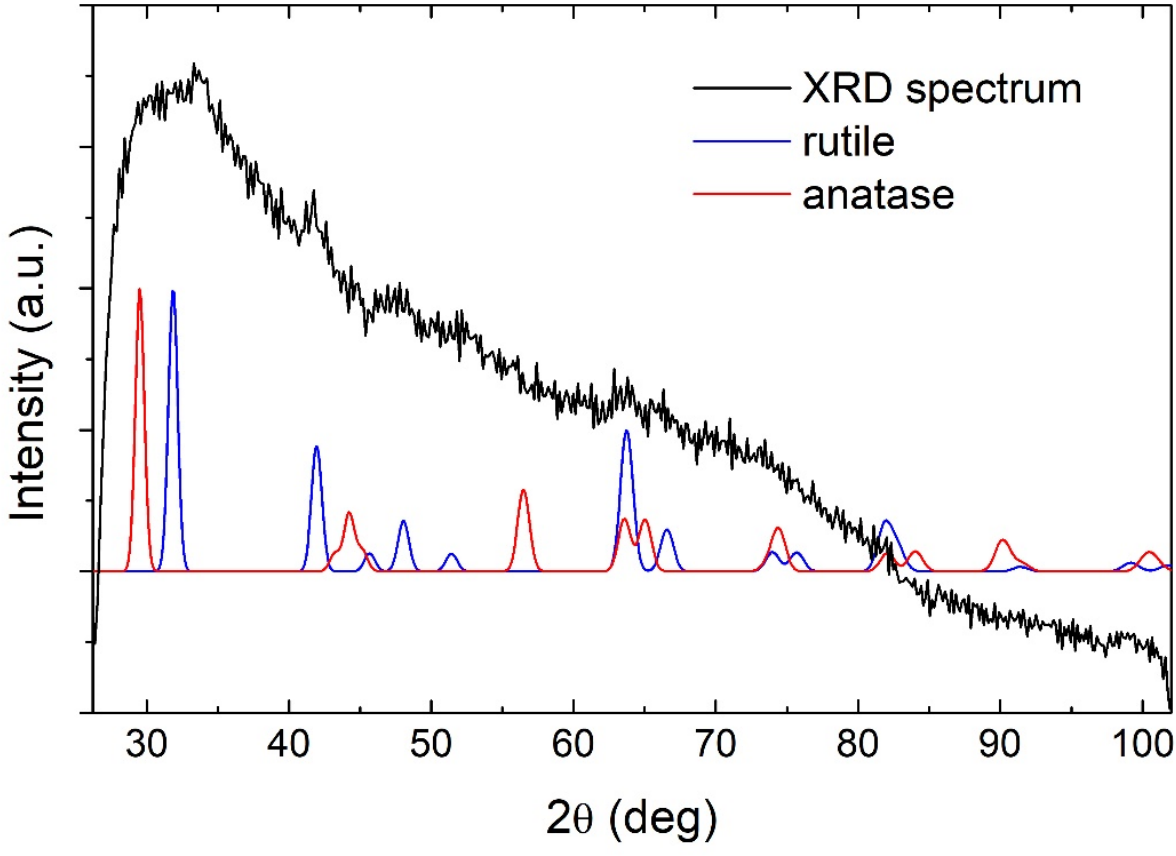
Figure 1. GIXRD pattern of TiO 2 nanoparticles.